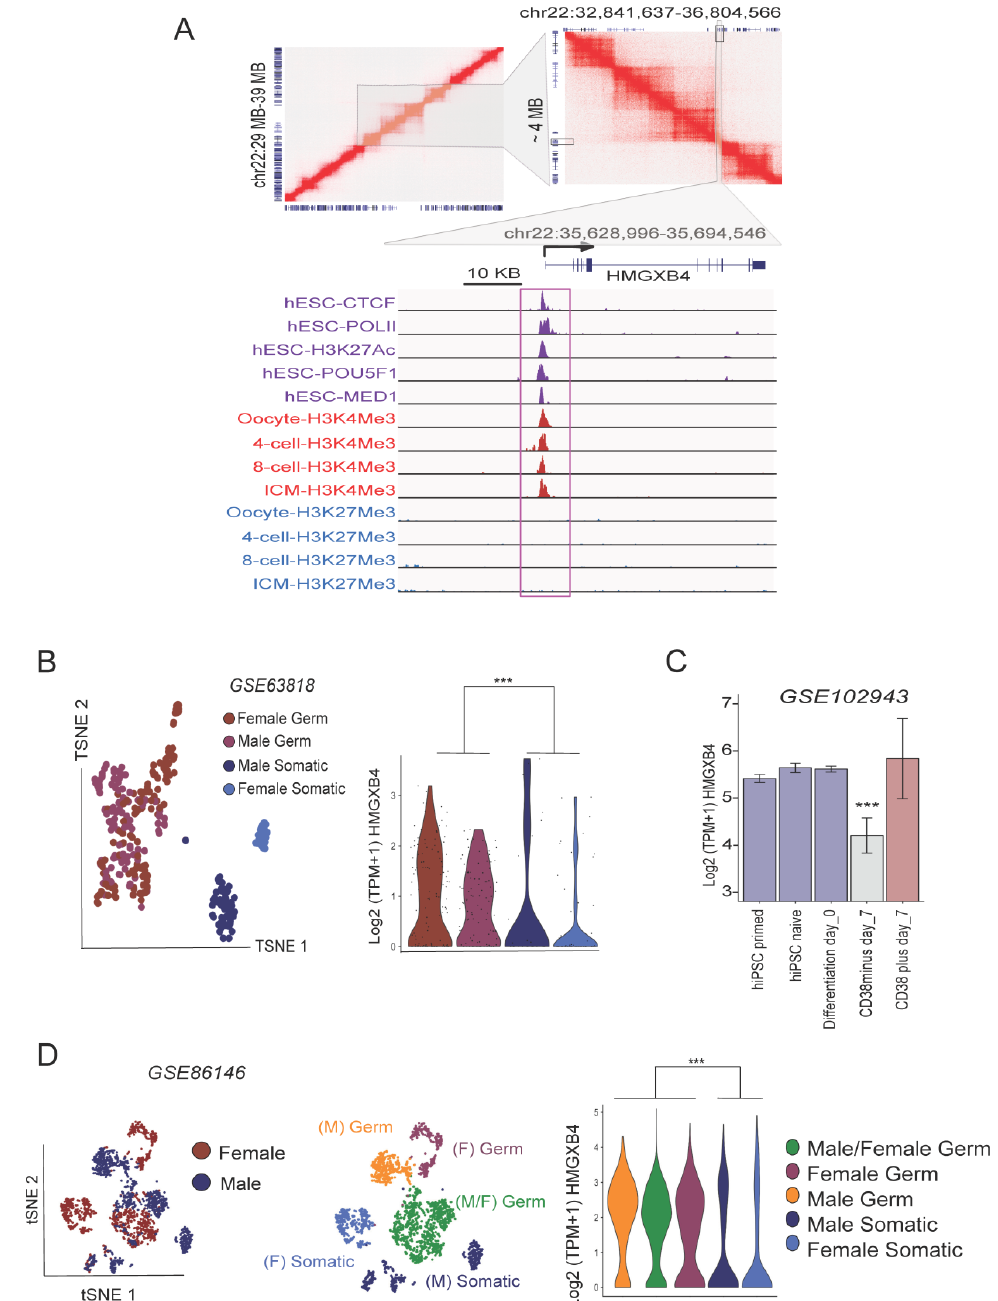
Figure 5. HMGXB4 Connects Pluripotent and Germinal stemness. ( A ) Upper panels: Pairwise contact matrices inferred from Hi-C data generated from human embryonic stem cells [47] (GSE116862) show a region between 29 – 39 MB on chromosome 22 at 5 kb resolution (left). The intensity of each pixel represents the normalized intensity of observed contacts between a pair of loci. The intensity of red color is proportional to the intensity of contact between two loci plotted on the X and Y axes. Gene models corresponding to these loci are placed on the bottom and left side of the map. Neighbor loops encompassing ~4 MB DNA sequence are further zoomed (right, gray shaded region). HMGXB4 gene is situated at the boundary of the interacting loop (boxed), which is further zoomed (lower panel, gray shaded region): Integrative genome visualization of the active loop boundary around the HMGXB4 locus. Binding profiles of ChIP-seq peaks (boxed) for CTCF, POLII, H3K27Ac, POU5F1 and MED1 (purple peaks) (GSE69646) [57] over the TSS of HMGXB4 (arrow). CUT&RUN profiling for H3K4me3 (dark red peaks) and H3K27me3 (blue peaks) in human germinal vesicle (GV)